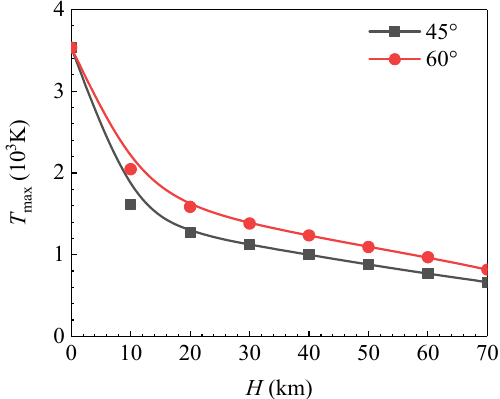
Figure 14. Maximum surface temperature with altitudes in two launching angles.